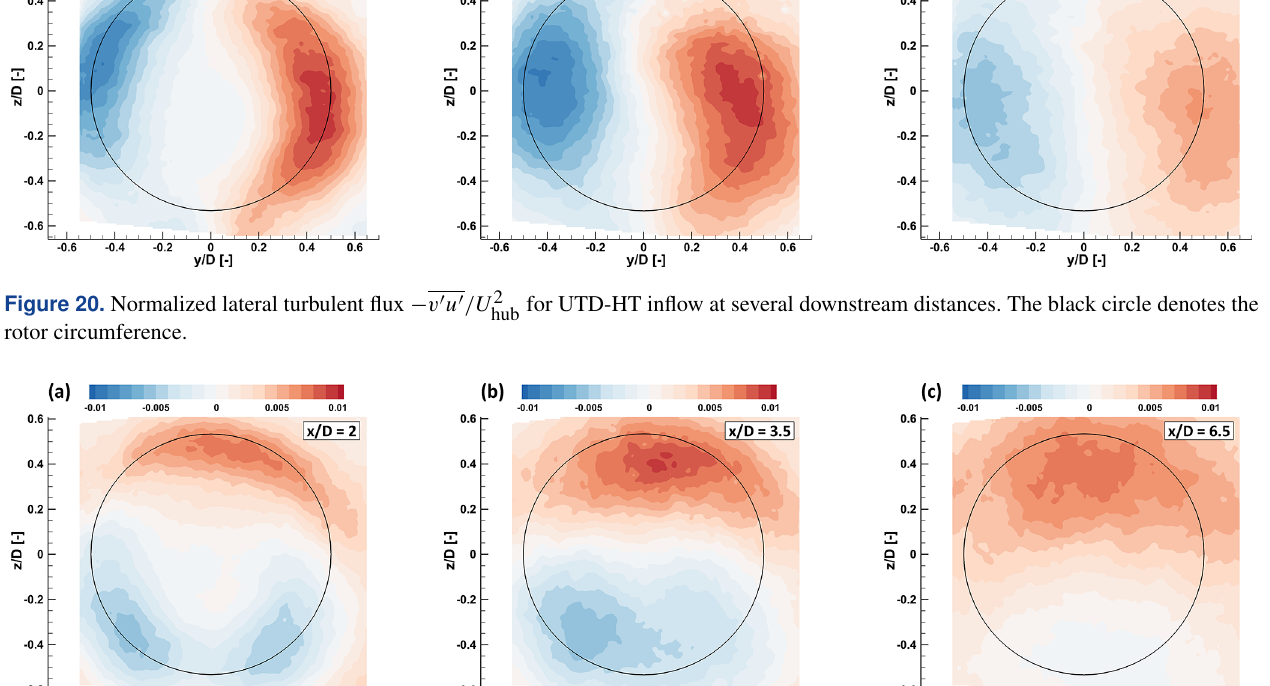
Figure 21. Normalized vertical turbulent flux − w (cid:48) u (cid:48) /U 2 the rotor